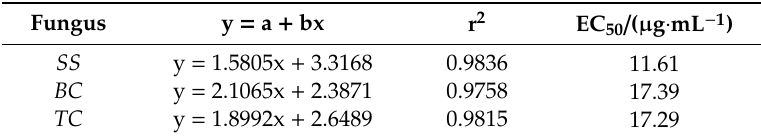
Table 5. EC 50 of compounds 7h to Sclerotinia sclerotiorum (SS), Botrytis cinereal (BC), Thanatephorus cucumeris